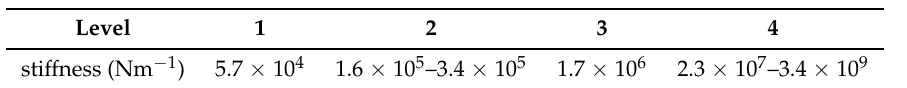
Table 6. Stiffness and level.